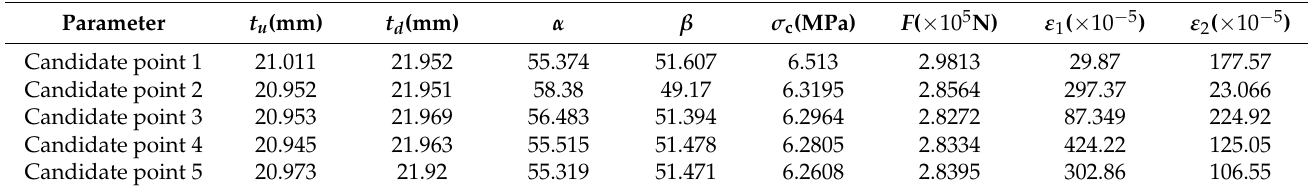
Table 7. Combination of optimal solutions for four